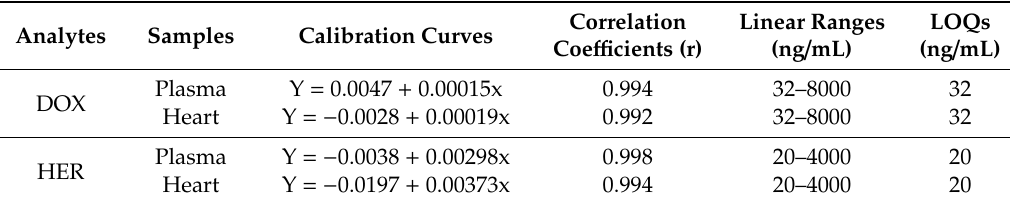
Table 1. Calibration curves of doxorubicin and hernandezine in plasma and myocardial tissue homogenate of rats.